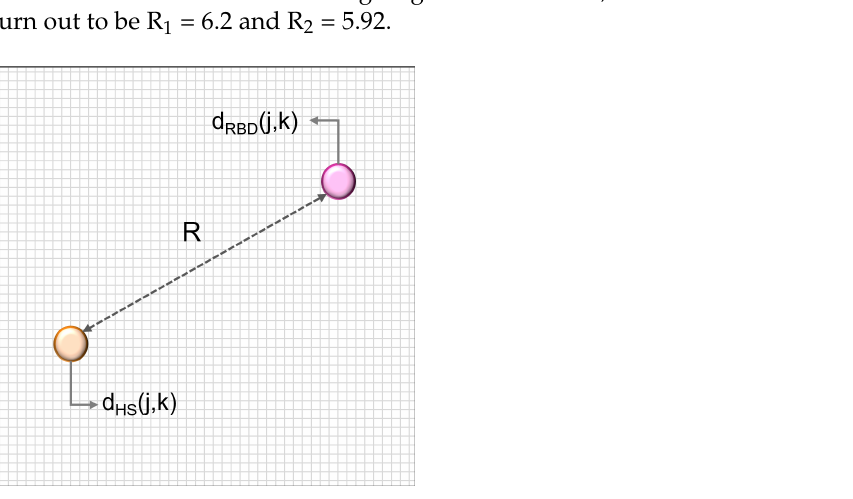
Figure 2. Neighbourhood R 2 computation. It is the Euclidean Distance between two points in space, representative of the healthy subject (HS, orange) and RBD groups (purple)